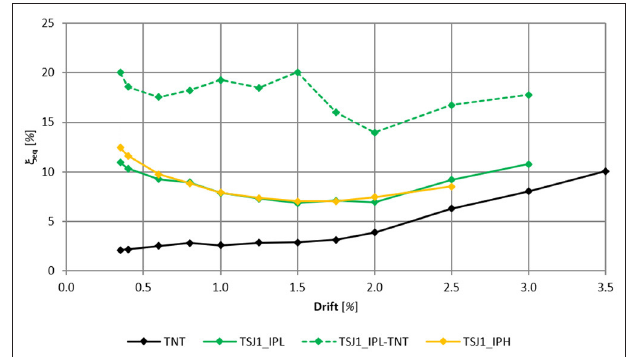
FIGURE 9 | Equivalent viscous damping of TNT, TSJ1 (for “low-” and “high-velocity” tests), and TSJ1-TNT at the first cycles.